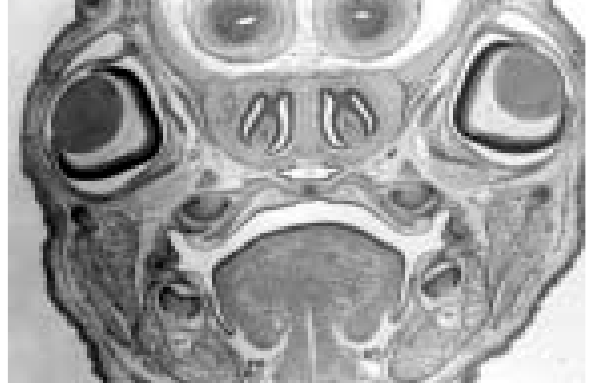
Figure 1 – Control Group – Frontal slice of the head of embryos. H&E. Magnification: 32X.